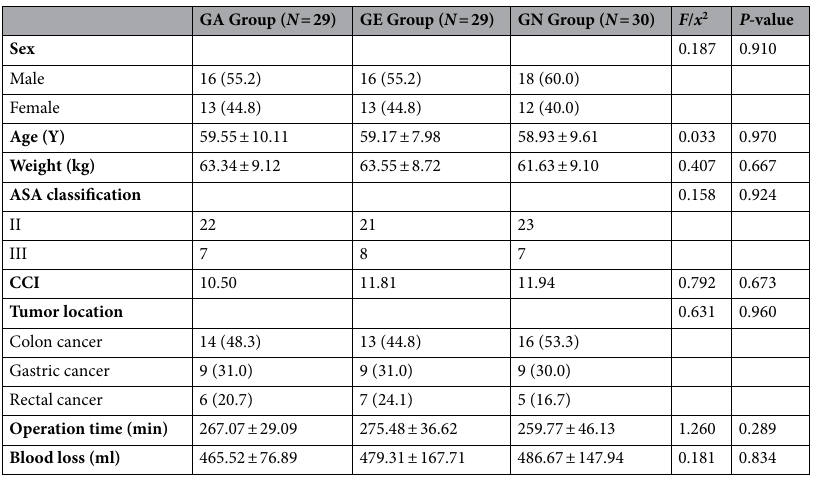
Table 1. Comparison of general clinical characteristics among the three groups. CCI Charlson Comorbidity